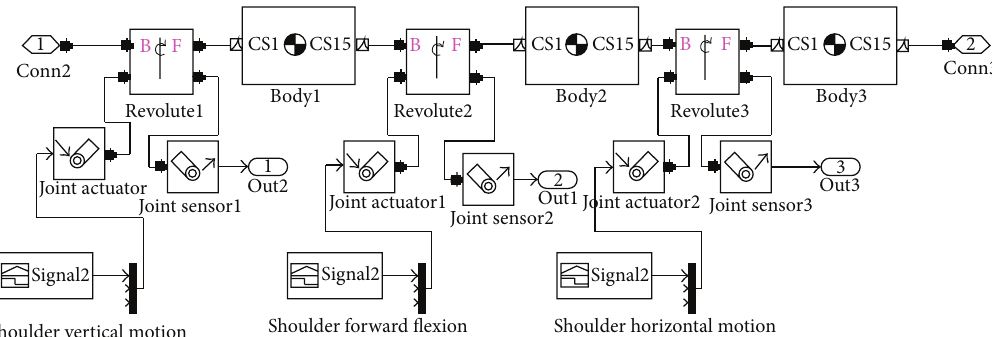
Figure 15: Block diagram below each human joint.